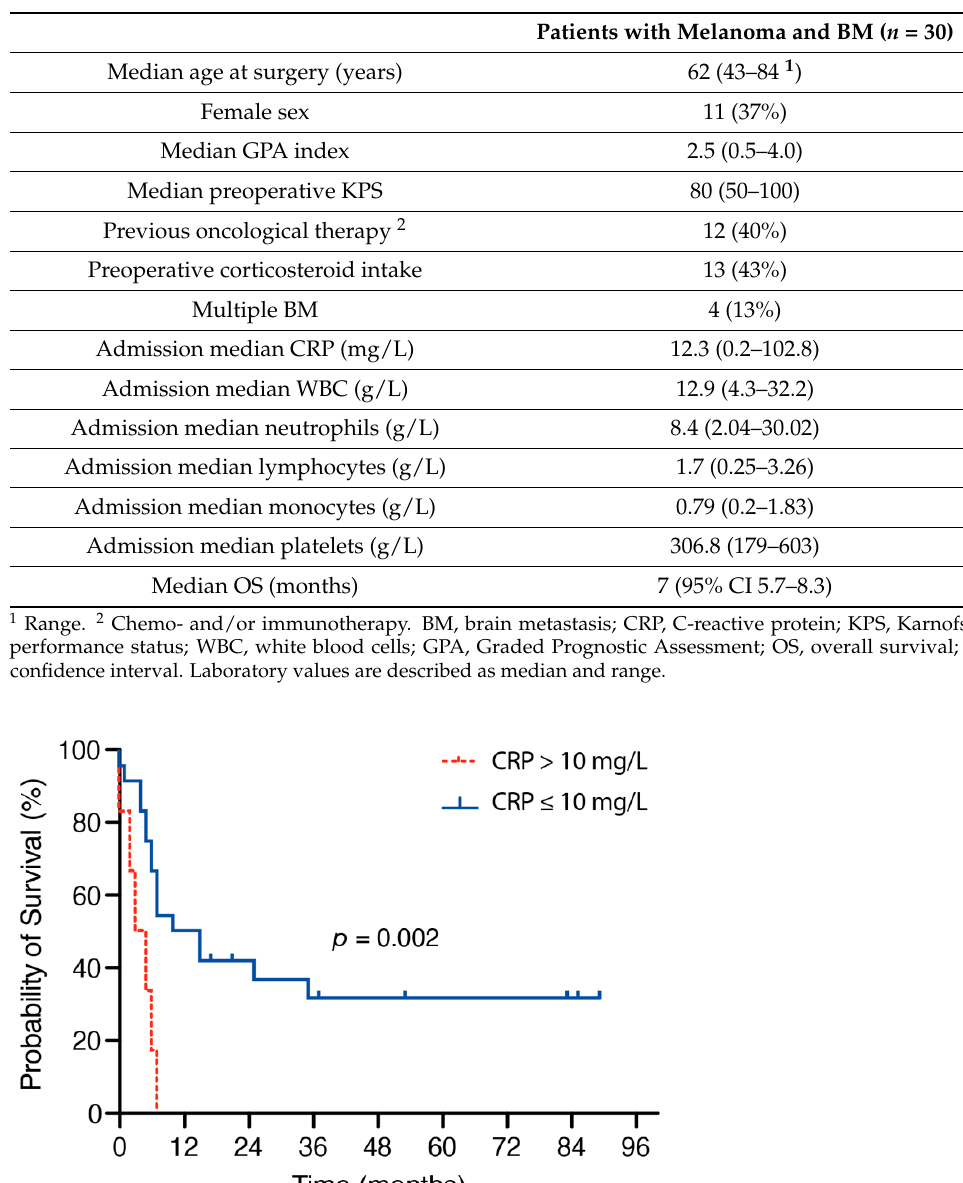
Table 1. Patient characteristics.